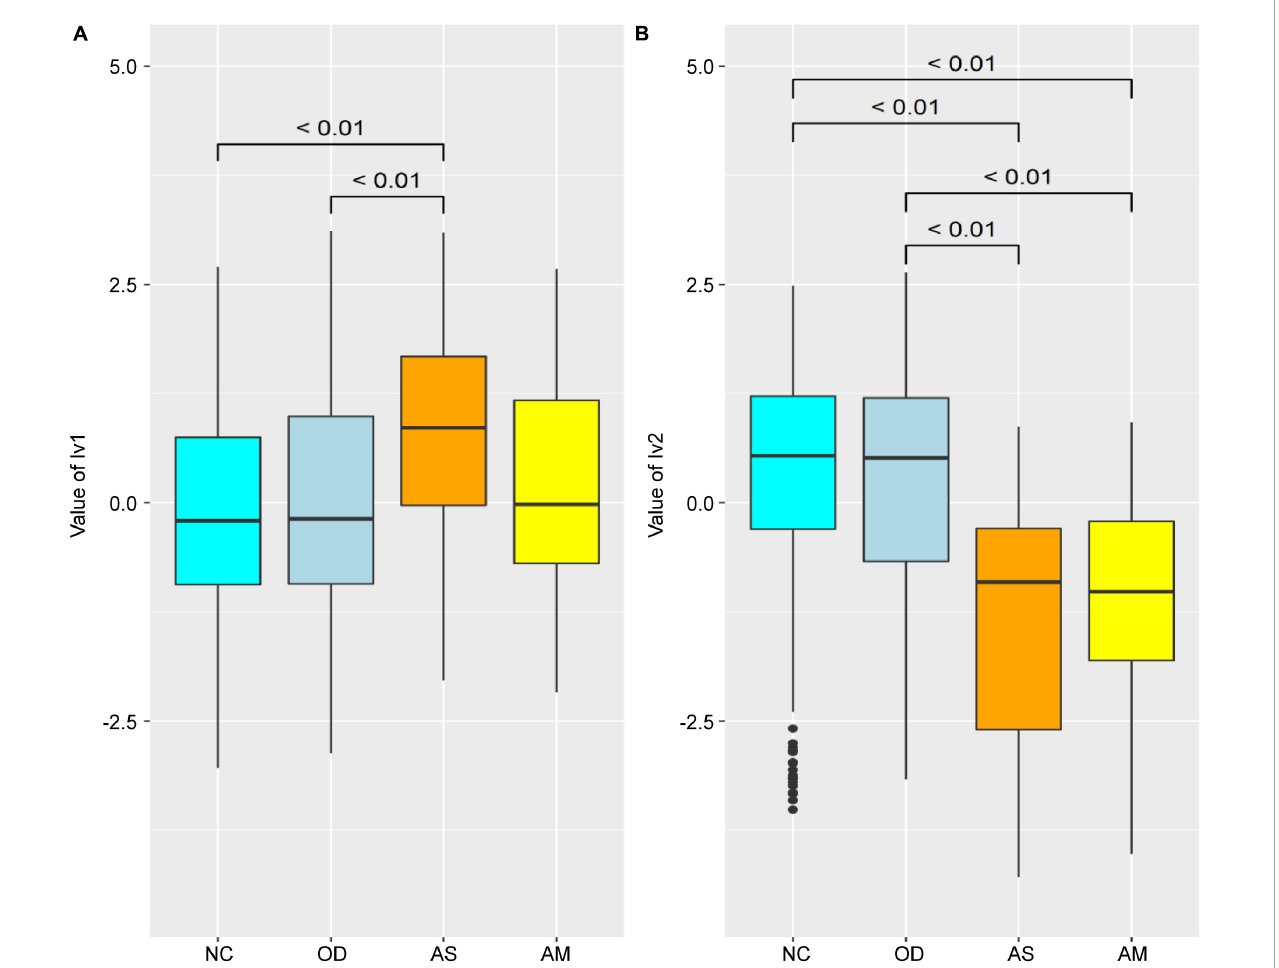
FIGURE4 Comparison of the latent variable values between groups for females obtained for each parameter of the structural equation model defined in Figure 3 . Latent variable values for (A) lv1 and (B) lv2. Numerical values on the boxplot represent the p -values in the Wilcoxon–Mann–Whitney rank sum test. NC: normal controls ( n = 321), AS: patients with atopic dermatitis without other diseases ( n = 45), AM: patients with atopic dermatitis with other diseases ( n = 75), OD: patients with other diseases but without atopic dermatitis ( n = 1,669). The bottom line of the box represents the first quartile value, the middle line represents the median, the top line represents the third quartile, and the points represent